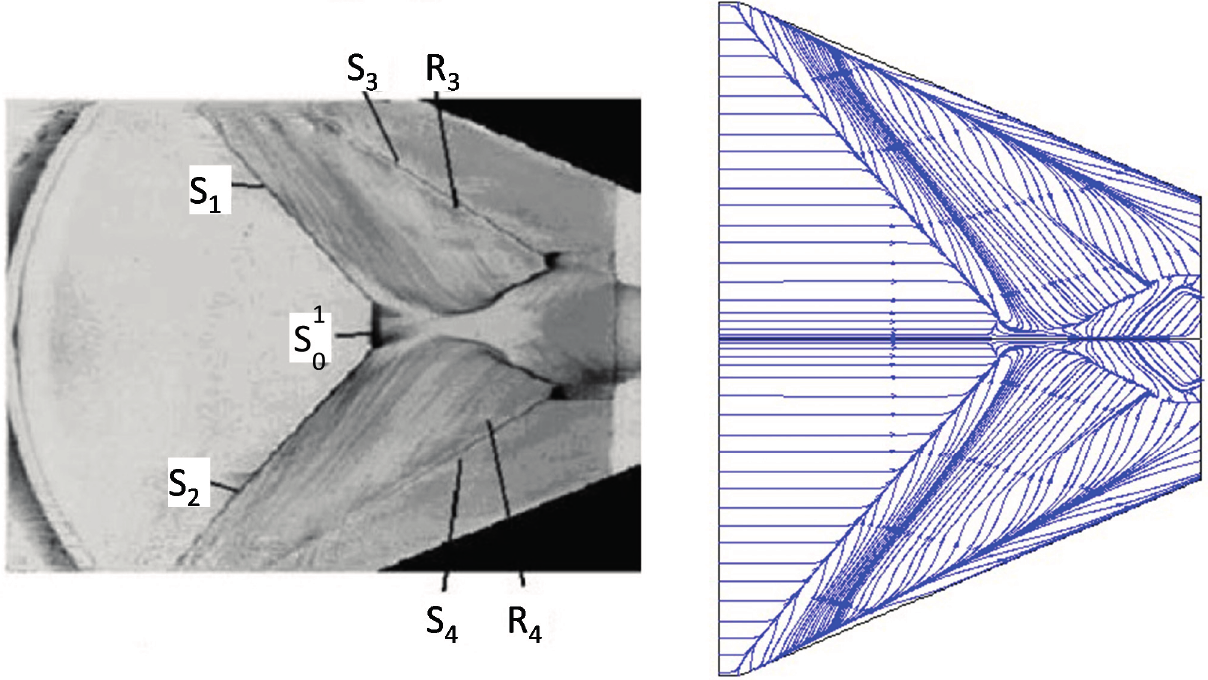
Figure 8. Comparison of surface streamlines with experimental oil-flow